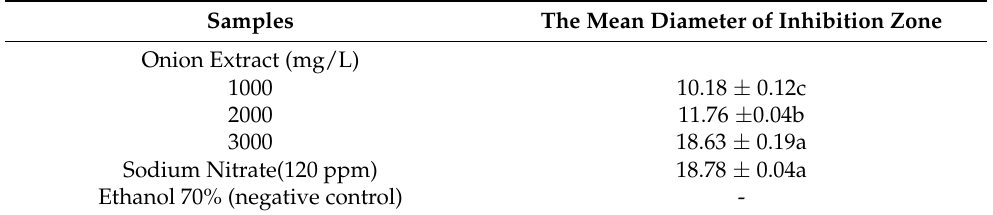
Table 6. The Effect of onion extract, Sodium Nitrate, and control on the diameter of inhibition zone of A. niger